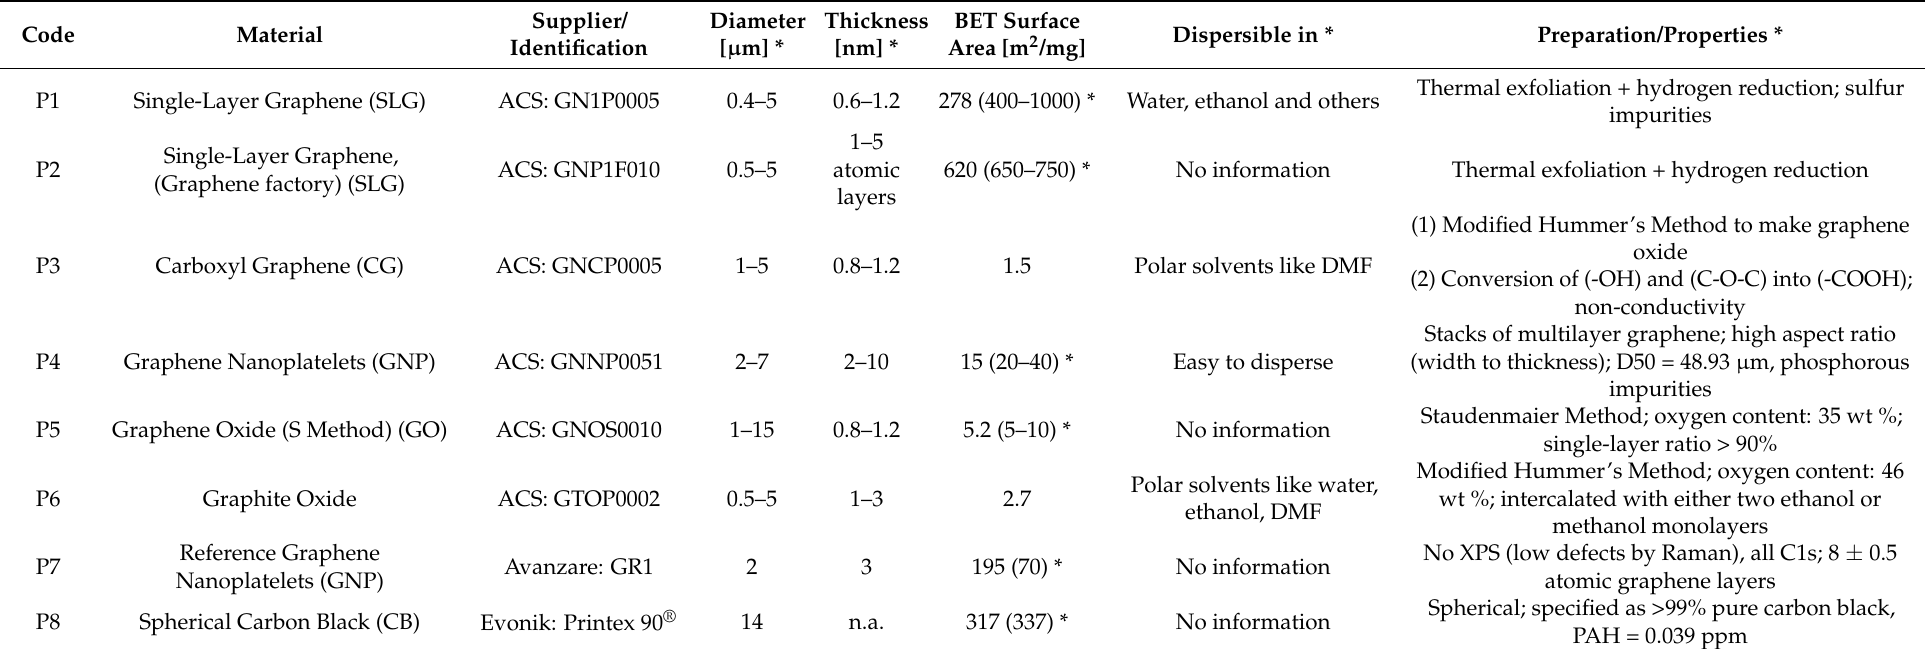
Table 1. GRNP materials, codes, providers, identification, characteristics and